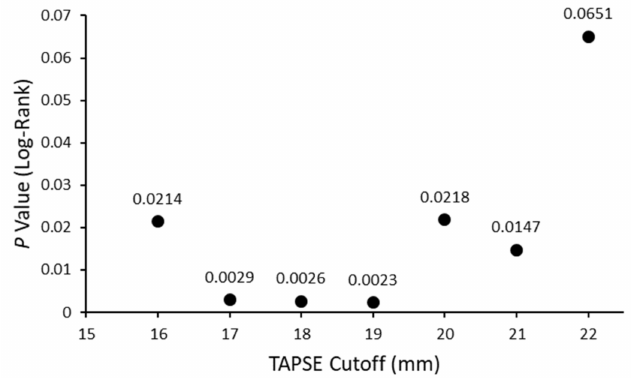
Figure A2. p Values for the log-rank test using different tricuspid annular plane systolic excursion (TAPSE) cutoffs to stratify